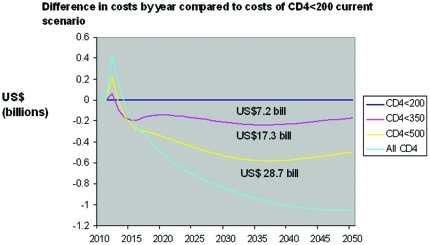
Annual cost by scenario compared to current prevention scenario baseline, 2010–2050.This figure shows the annual cost by ART scenario compared to the projected baseline of <200 current scenario. Totals represent cumulative cost savings over 2010–2050 time period. Cost neutral time points cluster around 2015. Discounted savings over 40 years are 3.9, 8.8, and 13.8 billion for <350, <500, and all CD4 cells, respectively.